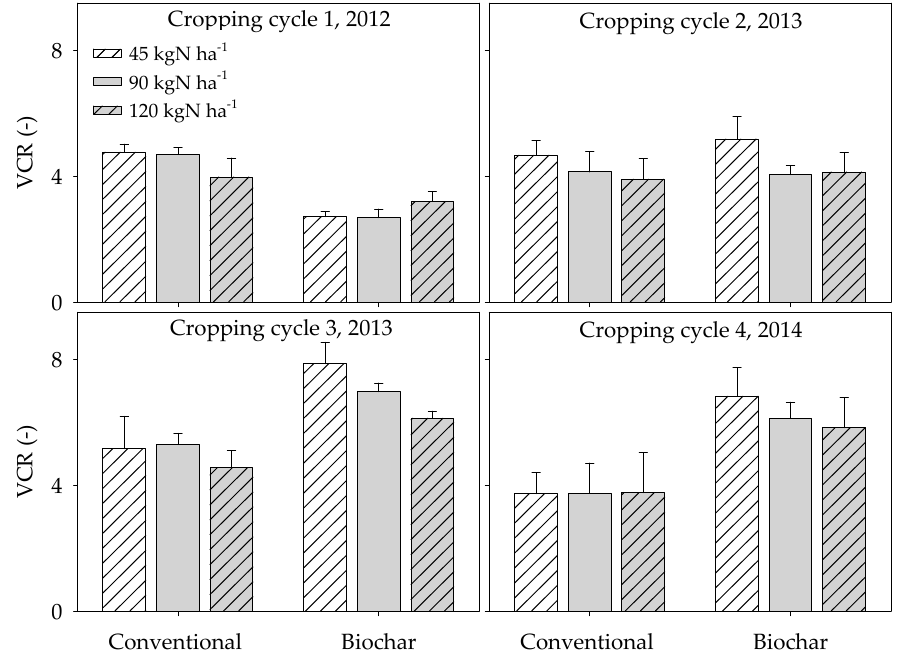
Figure 6. Value Cost Ratio (VCR) of biochar (10 t · ha − 1 ) and nitrogen fertilizer (kg · ha − 1 ) used in irrigated rice over 4 cropping cycles (2012–2014) at Kpong, Ghana. Error bars are standard deviations of the means. The 1st and 3rd cropping cycles were from July to November while the 2nd and 4th cropping cycles spanned the period December to April.